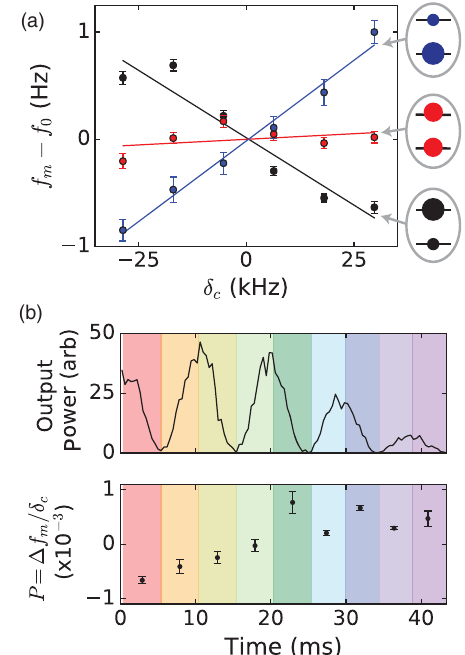
FIG. 4. (a) Sensitivity of superradiant light frequency f m to detuning of the cavity from resonance δ c for different initial population inversions, as shown in the side insets. An offset frequency f 0 set by the detuning of the reference laser from the strontium transition is subtracted for each data set. When tuned to minimize sensitivity to cavity detuning (red line and points) we observe a pulling coefficient P ¼ Δ f m = δ c ¼ 2 ð 3 Þ × 10 − 6 . Changing the duration of the state preparation pulse leads to an increased absolute value of P (black and blue points). (b) Atomic inversion changes throughout the superradiant pulse, leading to a chirp in the frequency of the emitted light for finite cavity detuning. The emitted power for a single shot is shown in the upper panel for the first 45 ms of the pulse. The pulling coefficient at different time intervals is computed from frequency measurements made on subsets of the pulse (as indicated by colored vertical bands) for the red data set shown in (a). The pulling coefficient of the entire pulse can be made insensitive to cavity detuning by choosing an initial inversion for which the time-averaged (weighted by instantaneous power) frequency shift is